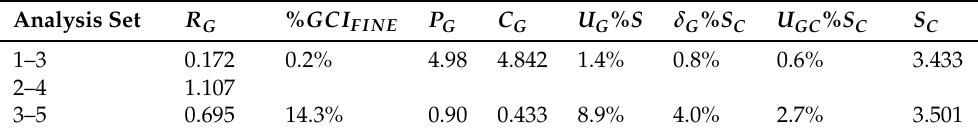
Table 9. Verification and Validation parameters considering grids 1–5 for SUB-OFF submarine at Fr = 0.466 and H / D =